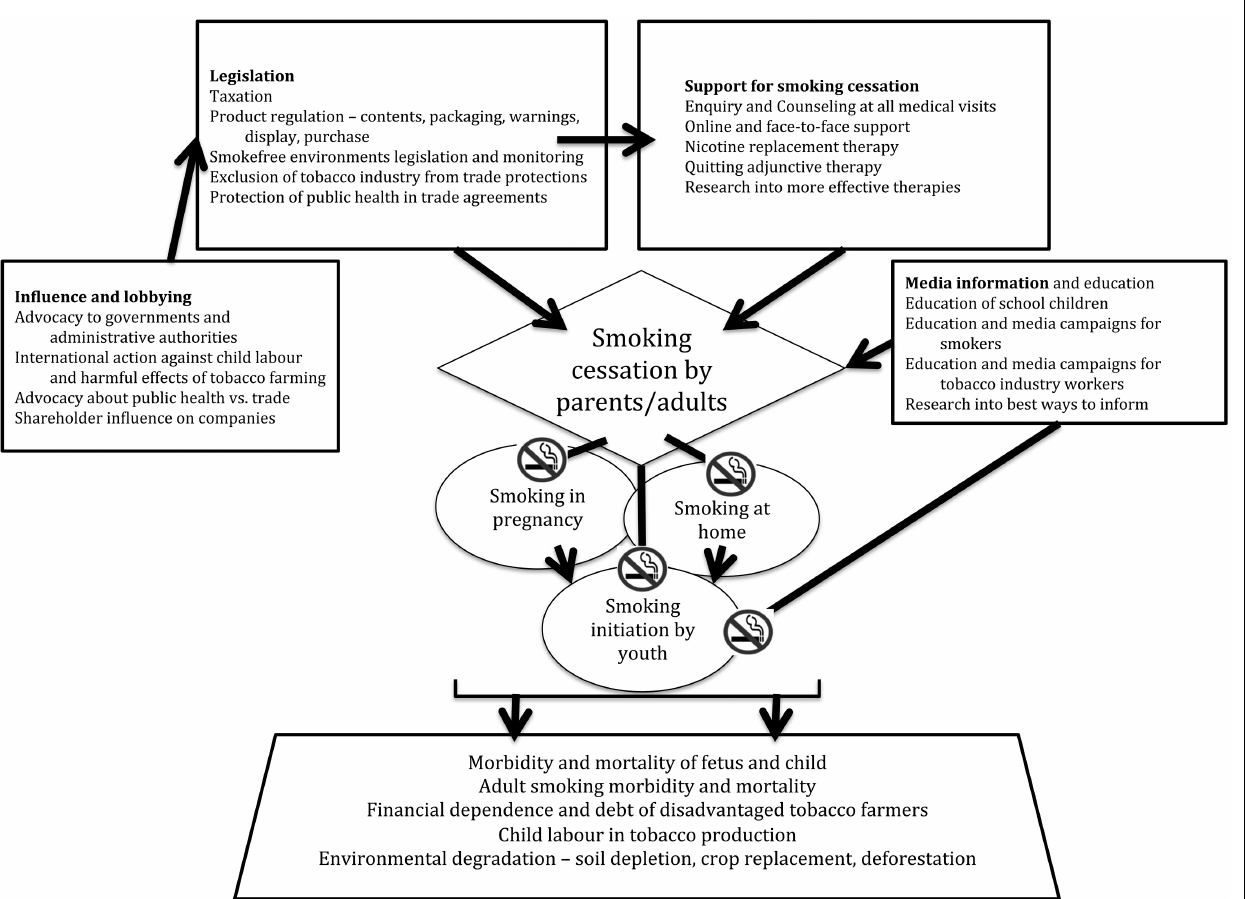
FIGURE 1 | Multi-pronged approach to reducing tobacco-related mortality, morbidity, and smoking initiation among children, focused on reducing smoking prevalence in adults